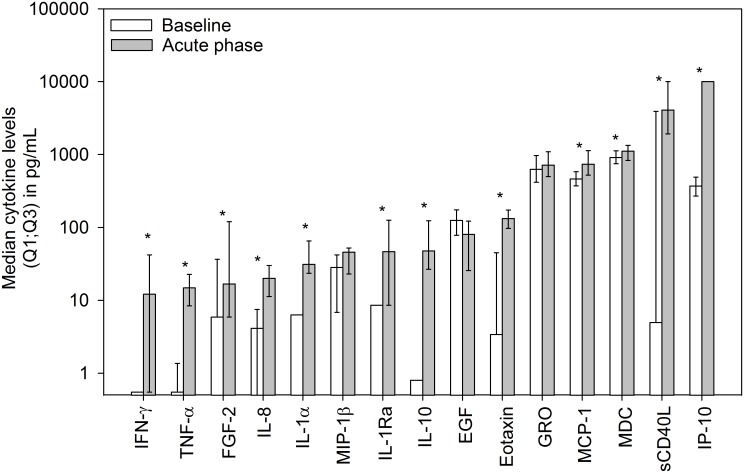
Differentially expressed cytokines in acute samples as compared to baseline.Median cytokine values in children at baseline (1 month post-dose 3) (N = 40) and during the acute phase of dengue illness (N = 33) irrespective of treatment group. Upper error bars represent the 75% (Q3) percentile; the lower error bars represent the 25% (Q1) percentile. Cytokines with a significant difference (p<0.05) are marked with an asterisk. Values below the lower limit of quantification were replaced by half of the limit of quantification.